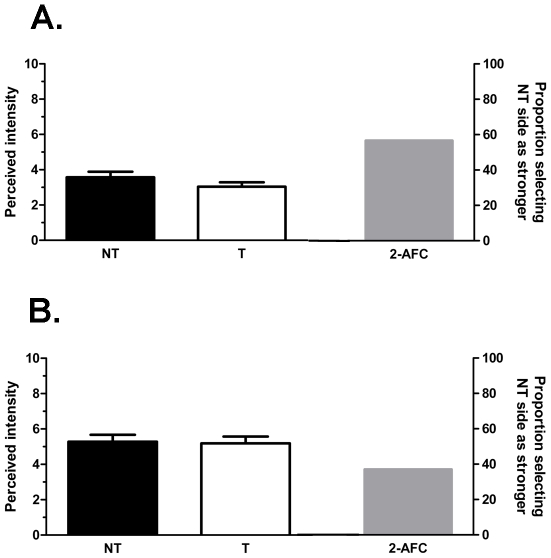
Lack of cross-desensitization of IBA-evoked tingle.Desensitization was assessed following lingual pre-treatment with (A) capsaicin (10 ppm) or (B) mustard oil (0.125%). Both panels show the bilateral intensity ratings and 2-AFC data when tested after the capsaicin (A) or mustard oil (B) burn had subsided. The format is the same as in figure 2.